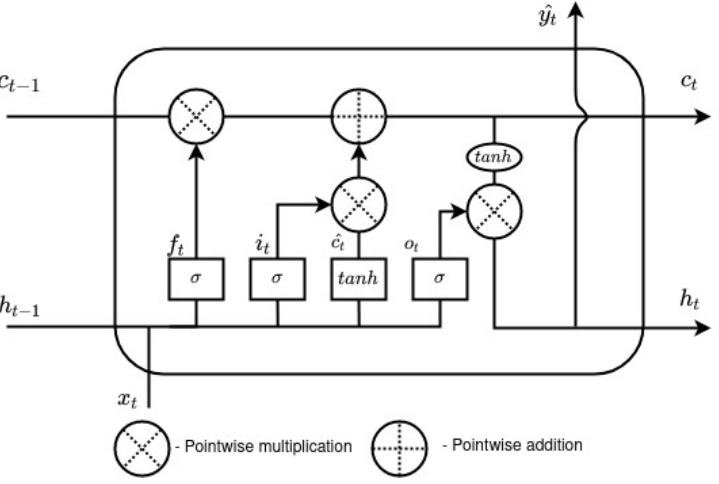
Figure 3. Structure of a long short-term memory unit cell